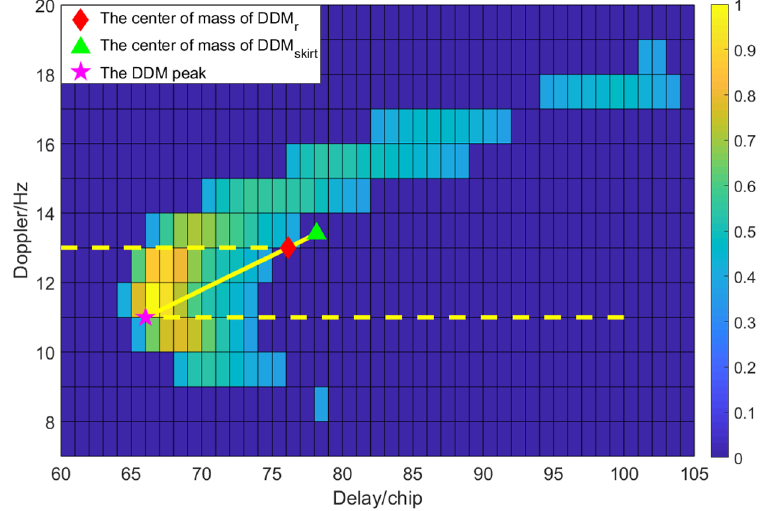
Figure 2. Extracting feature parameters of the geometric relationships ϕ 1 and ϕ 2 from the DDM of a 90° wind direction.